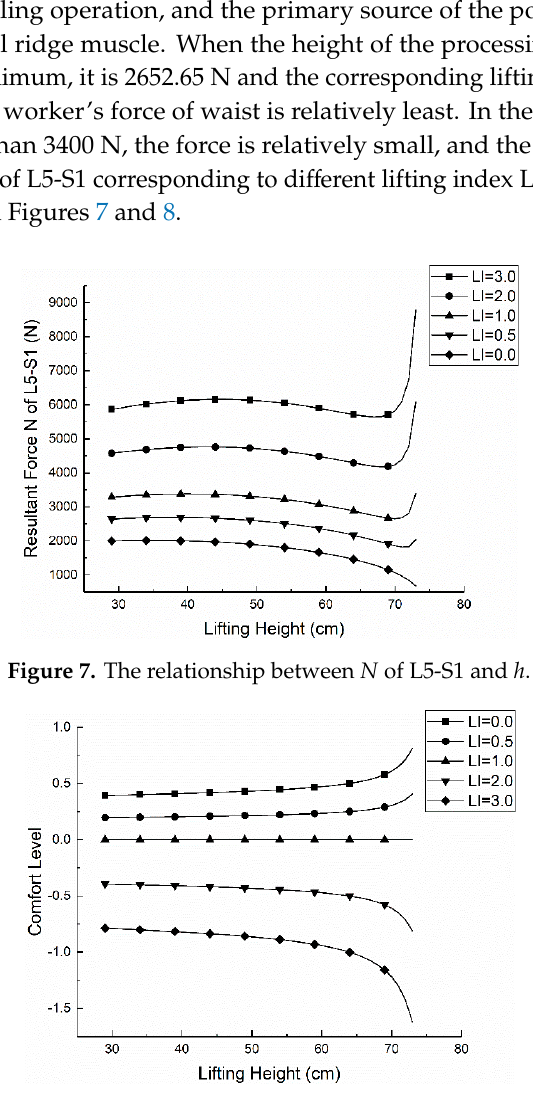
Figure 6. The relationship between N of L5-S1 and h .